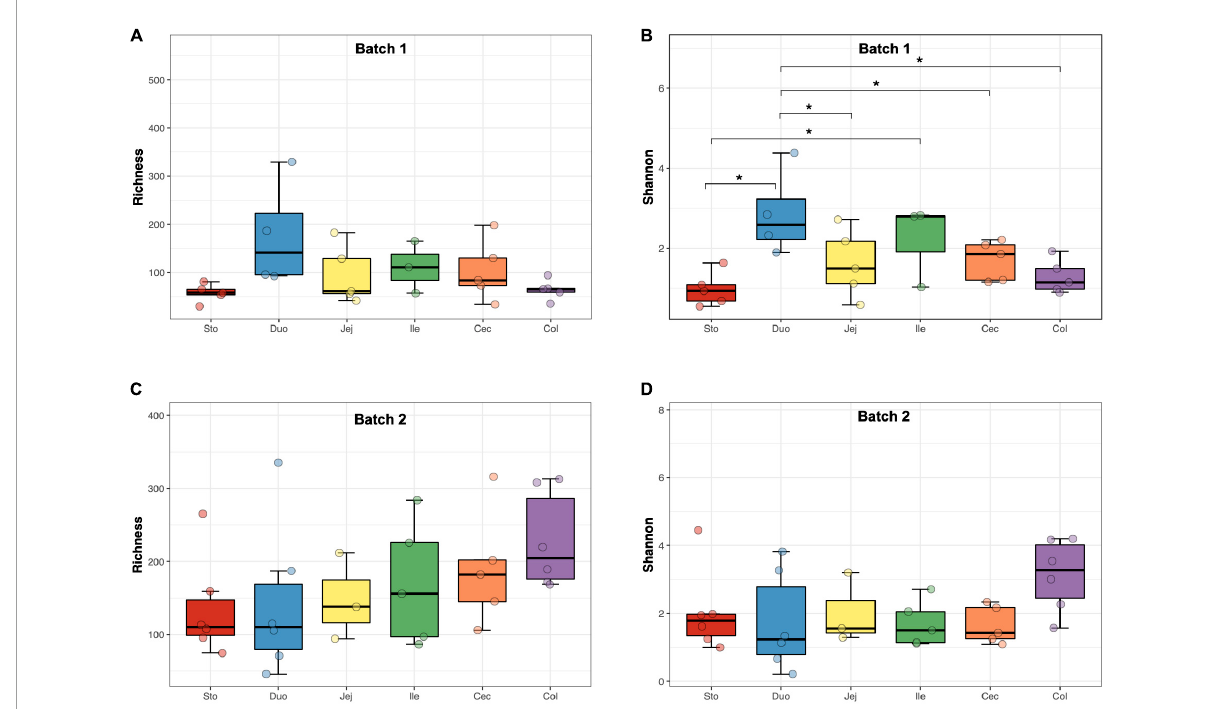
FIGURE1 The α -diversity of the fungal community in different regions of the gastrointestinal tract in the pigs. (A) Richness (batch 1). (B) Shannon index (batch 1). (C) Richness (batch 2). (D) Shannon index (batch 2). Significance is indicated by “*” when p <